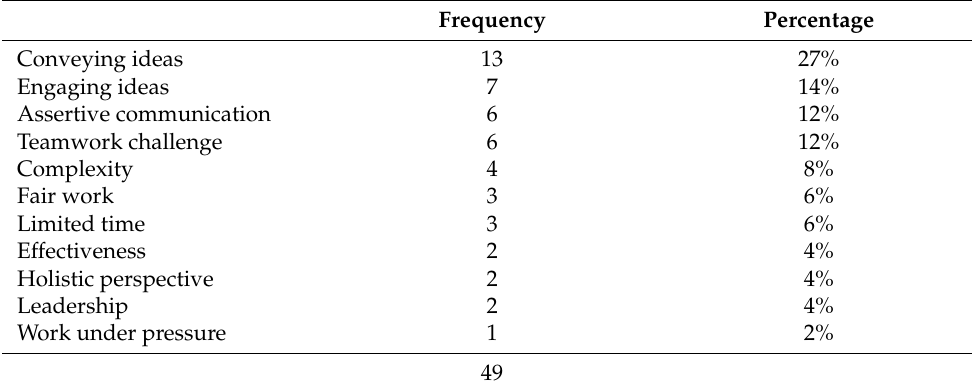
Table 1. Challenges in team work.